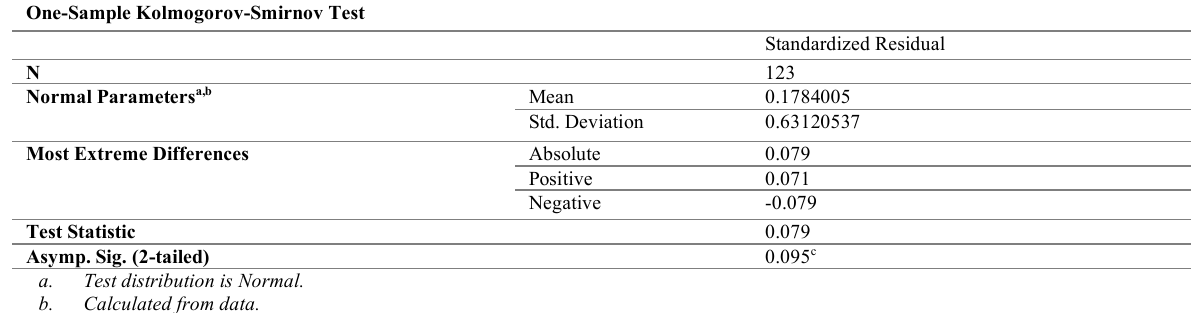
Table 4 : Data Normality Test Results (Job satisfaction)